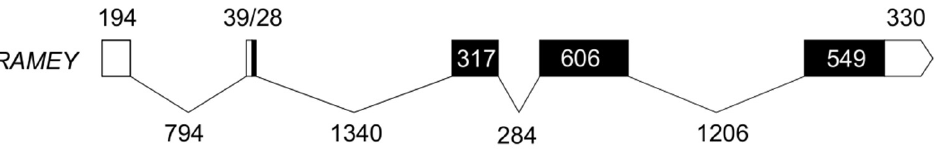
Figure 1. Genome structures of the ovine PRAMEY . PRAMEY contains five exons and four introns. Black boxes represent coding regions, and white boxes represent 5 ′ UTR and 3 ′ UTR regions. The UTR, introns, and exons are drawn to scale.